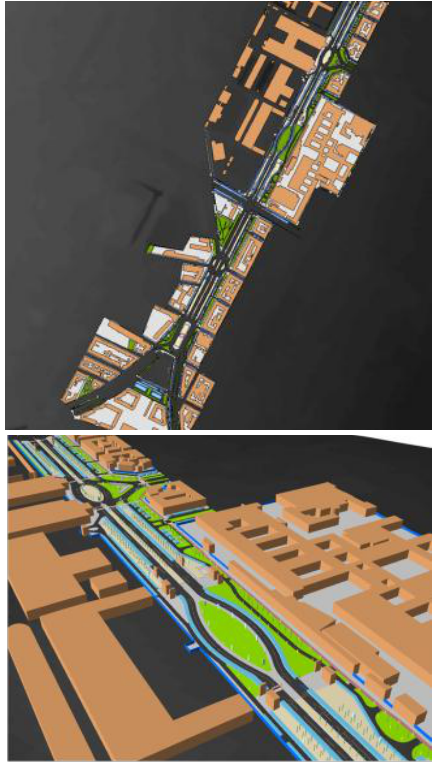
Figure 6. 2D and 3D GIS model of the test site